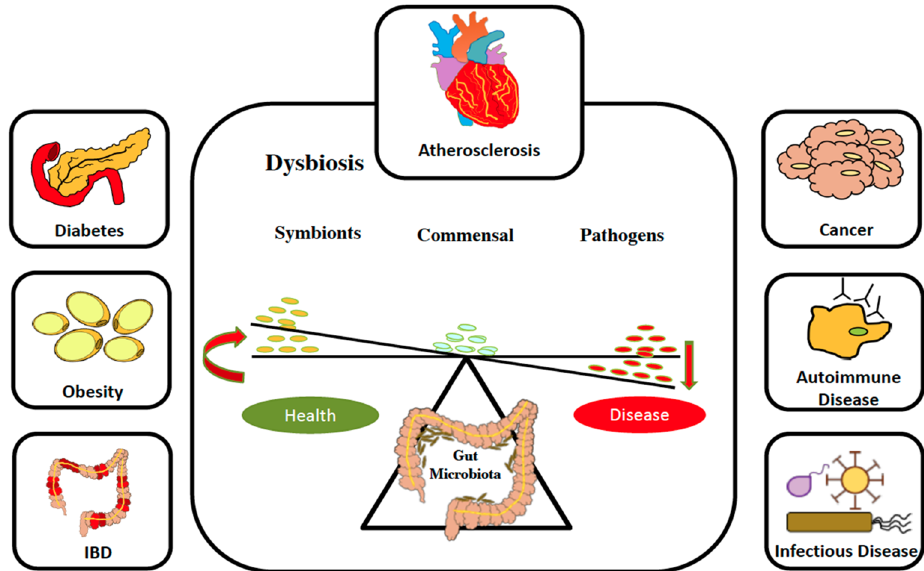
Figure 1. The microbiota is important for overall health. The balance between health and disease is regulated by microbiota in many ways. Microbiota in equilibrium is linked with homeostasis; when it is perturbed, it leads to dysbiosis and diseases.